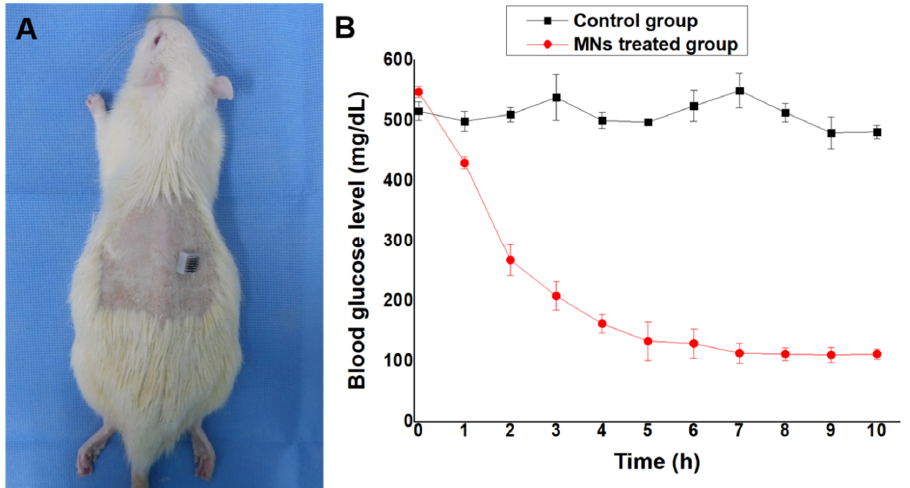
Figure 6. In vivo insulin release in diabetic rats. ( A ) Photograph of diabetic rat treated with MNs. ( B ) blood glucose levels after application of control and insulin loaded MNs. Error bars indicate SD ( n = 4).